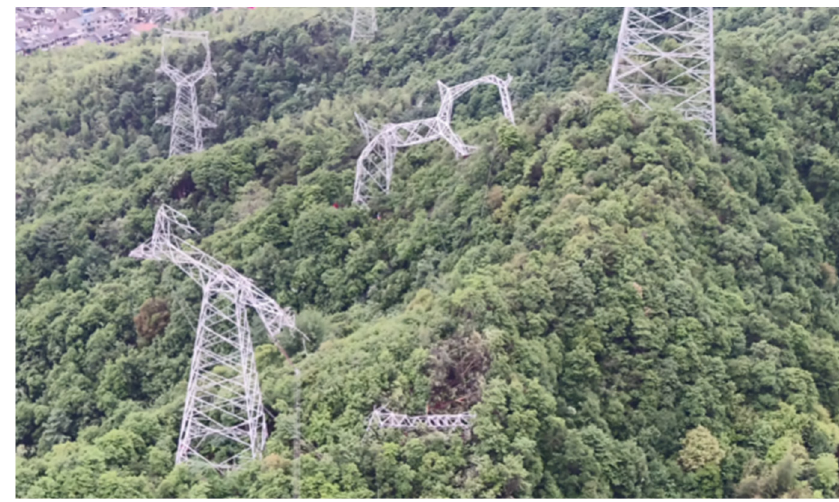
Figure 1. Collapses of transmission towers following a downburst.